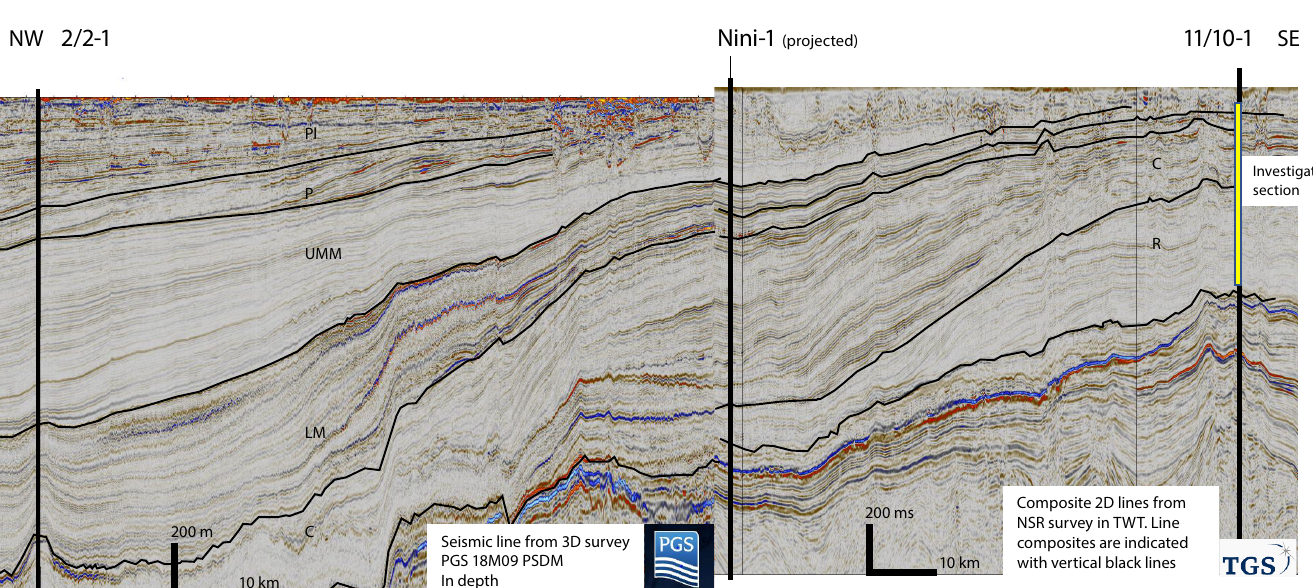
Figure 31. Composite 3D and 2D lines from the Central Graben to the Farsund Basin in the southernmost part of the Norwegian sector of the North Sea. The line is tied to the Nini–1 well in the Danish sector with a slight projection. The 3D line to the west is in depth while the composed 2D line to the right is in twt. The line displays the seismic character of the Oligocene Vade Formation pinch-out from east to west. The Miocene and younger sediments are fine-grained in this area, but distal clinoforms are interpreted. The Pliocene (P) seems to be complete, with upper and lower Pliocene represented. PL – Pleistocene, UMM – Upper and middle Miocene, LM – Lower Miocene, C – Chattian, R – Rupelian. See Fig. 2 for location.